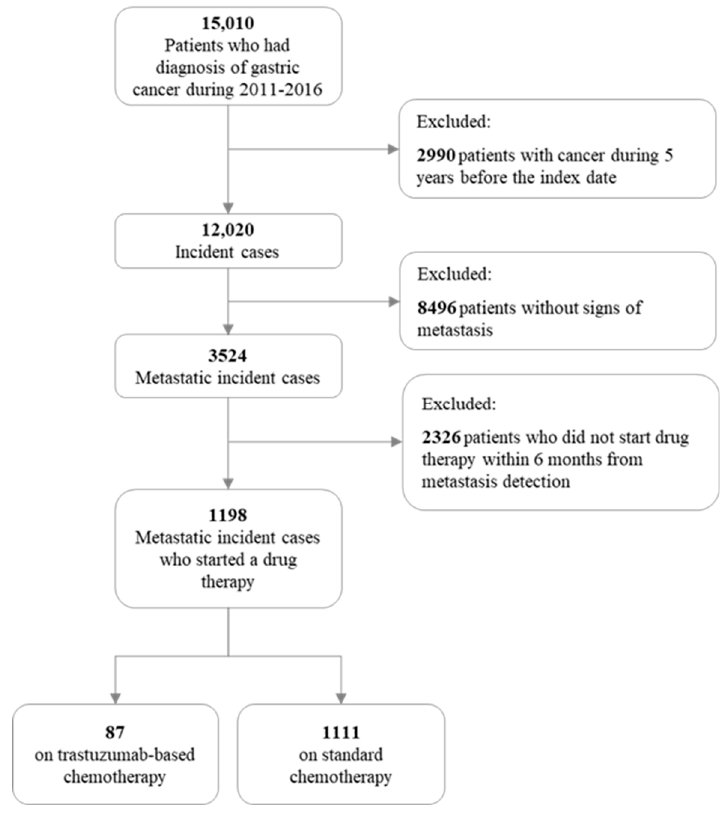
Figure 1. Flow chart of the inclusion and exclusion criteria in the final cohort study.